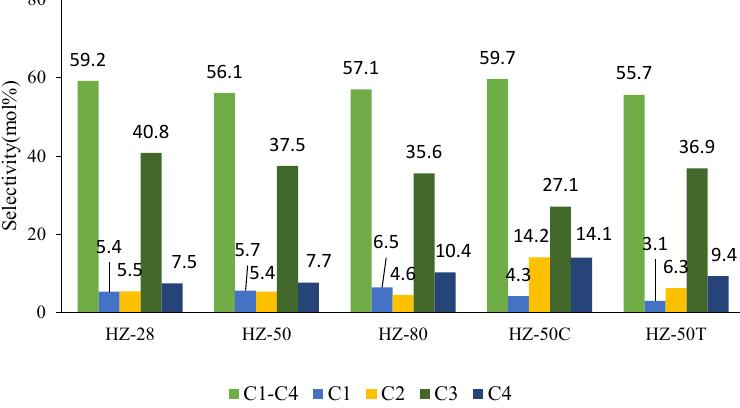
Fig. 9. Gaseous hydrocarbon as carbon number in HZ-28, HZ-50, HZ-80, HZ-50C, HZ-50T samples for P = 1atm, T = 400 º C, WHSV = 3 h -1 .